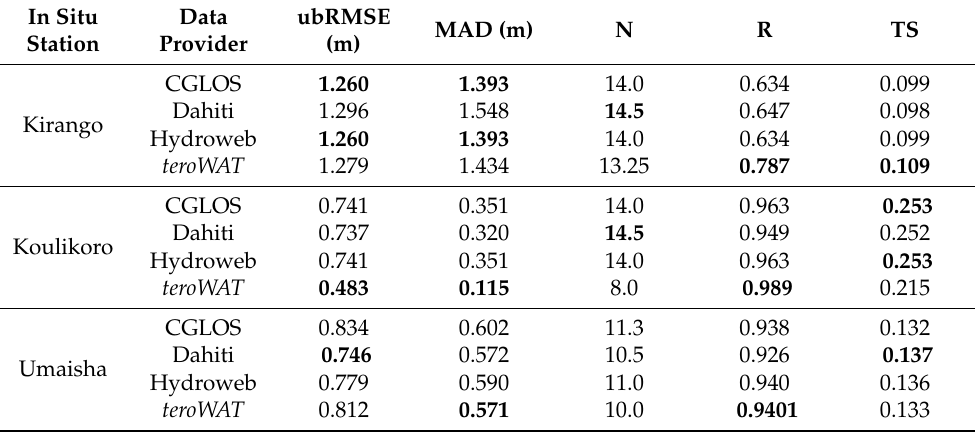
Table A2. Detailed averaged metrics of VS-mission time-series for 3 in situ stations (Kirango, Koulikoro, Umaisha) in West Africa for CGLOS, Dahiti, Hydroweb and teroWAT data providers.. Bold values represent the best statistically significant